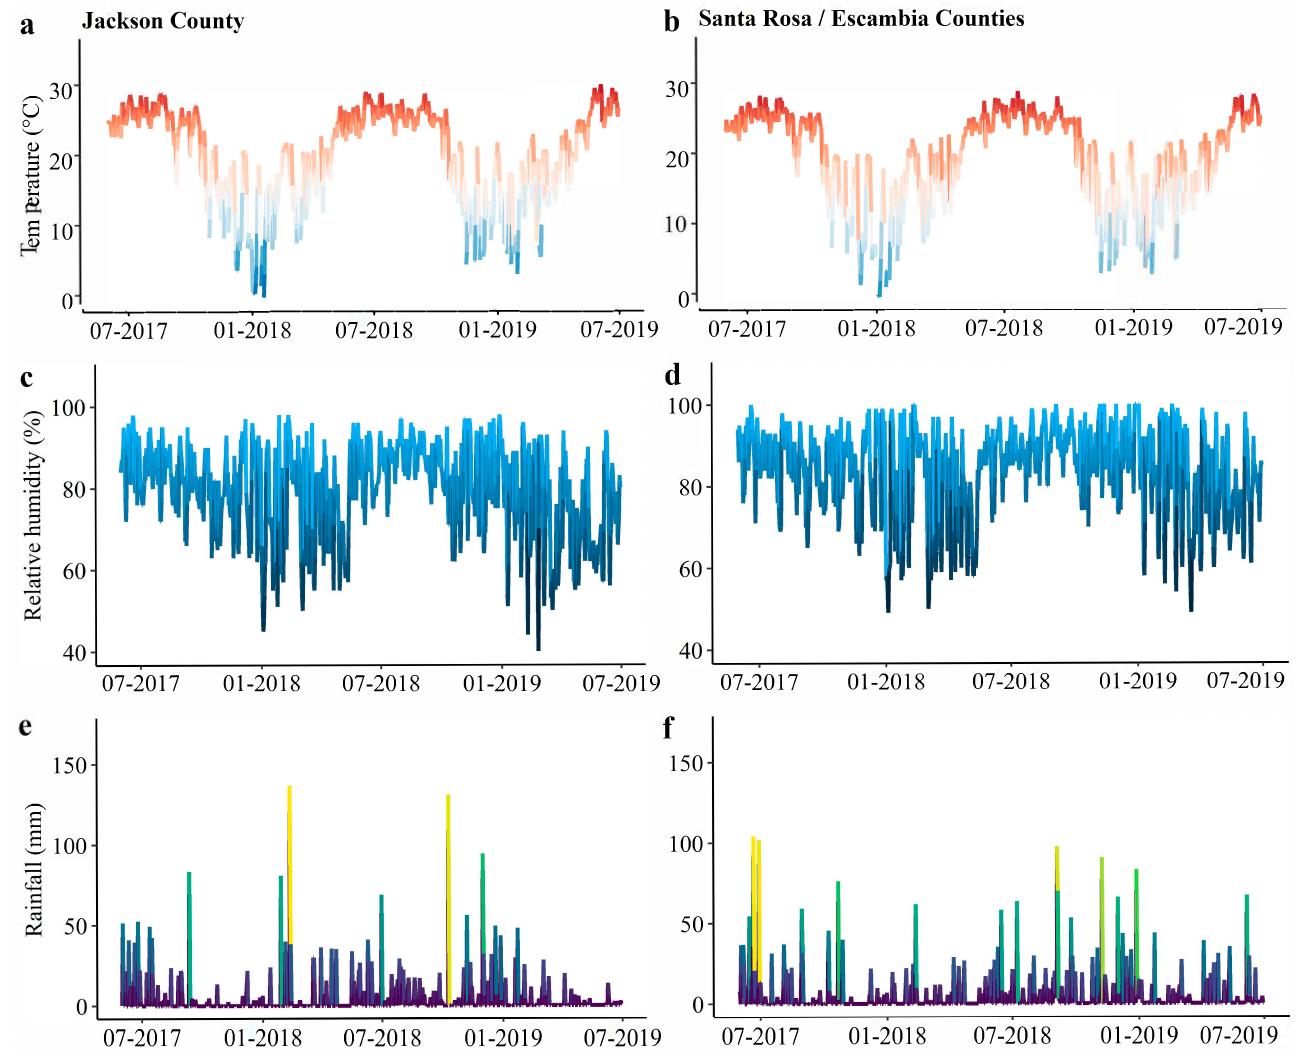
Figure 4. ( a ) Average daily temperature, ( c ) relative humidity, ( e ) and daily accumulated rainfall, from 2017 to 2019 in Marianna, Jackson County. ( b ) Average daily temperature, ( d ) relative humidity, and ( f ) daily accumulated rainfall from 2017 to 2019 in Jay, Santa Rosa County. Table 2. Weather variables association with H. zea moth catch in Jackson and Santa Rosa/Escambia, Florida, from June 2017 to June